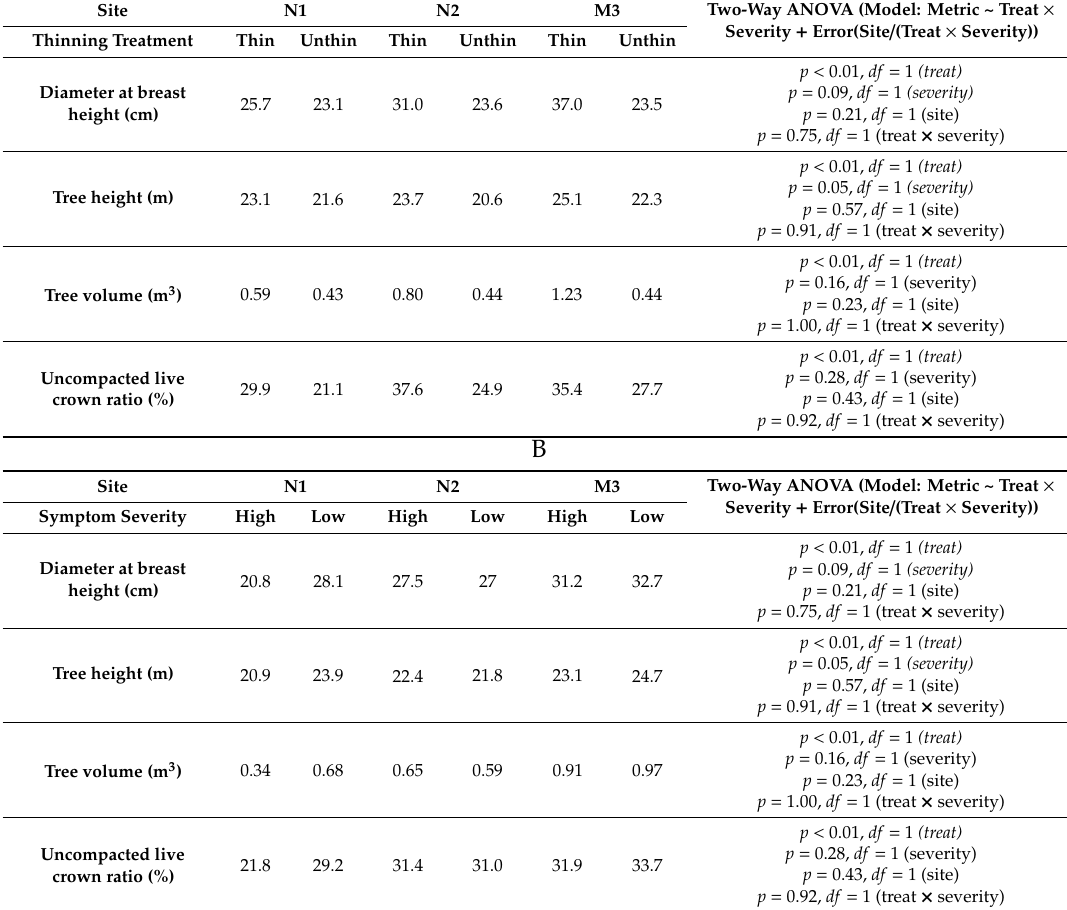
Table A2. Summary statistics for 36 sampled eastern white pine ( Pinus strobus L.) trees. In each site, 12 trees were felled and destructively sampled, 6 each per thinning treatment (“Treat;” Thin, Unthin), and within each treatment 3 per symptom severity class (High, Low). The p-values and degrees of freedom are reported; p-values in italics are significant at the p ≤ 0.10 level. The means are reported for both (A) thinning treatment and (B) Caliciopsis symptom severity